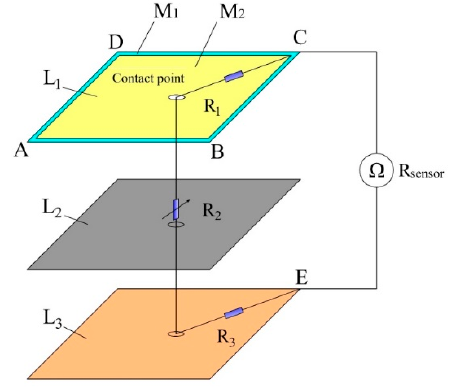
Figure 7. The resistance model for detecting contact force.